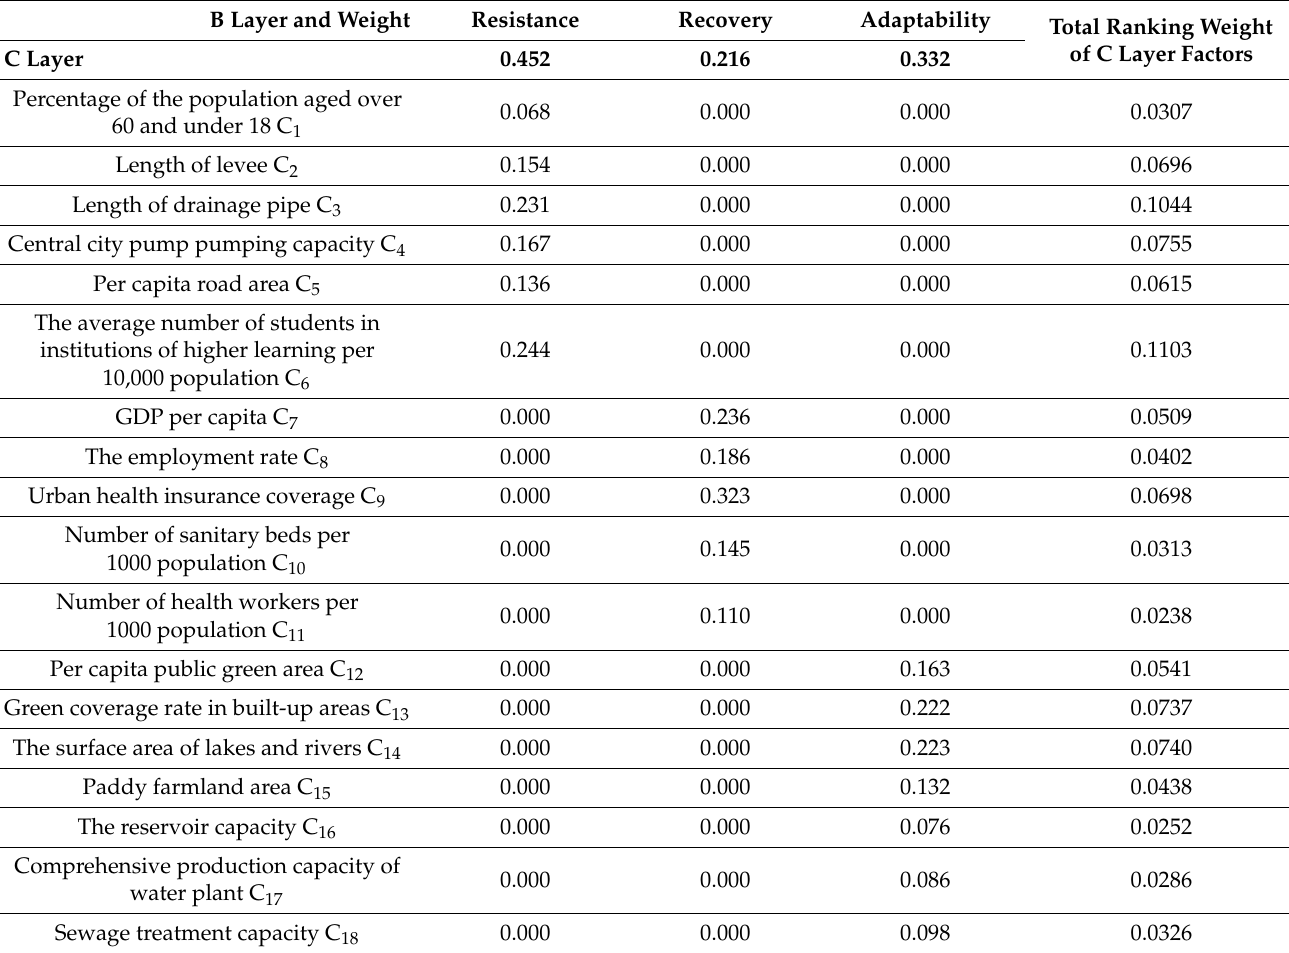
Table 4. Weight table of urban stormwater resilience evaluation